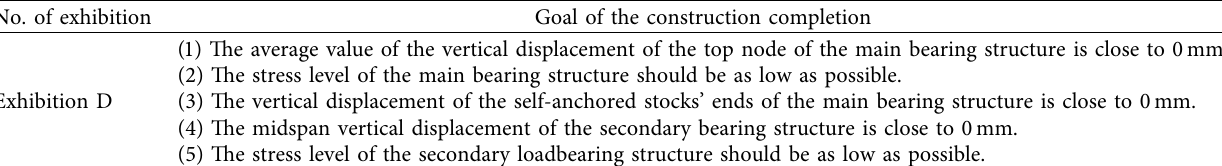
Table 1: Goal of the construction completion.